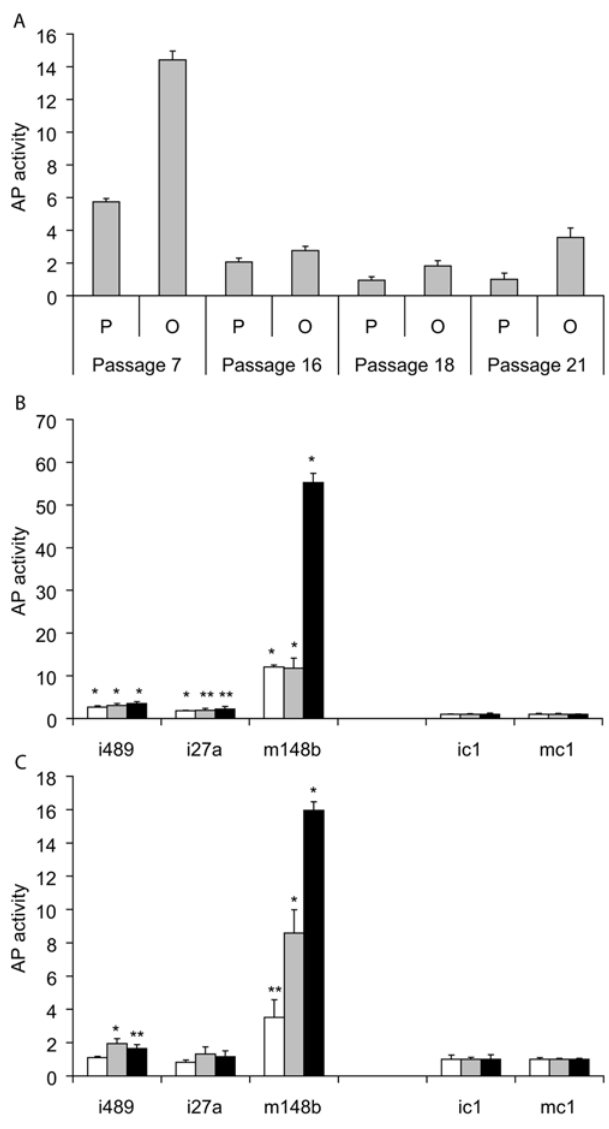
Figure 3. Alteration of the miRNAs activity rescues osteogenic potential in transfected hMSC with high passage number. (A) Bone marrow hMSC with high passage number demonstrate a decrease in basal level of AP activity and poor response to differentiation media. hMSC were plated in 96-well plates and incubated either in propagation (P, grey bar) or osteogenic (O, black bar) media for 6 days. Data normalized to relative AP activity values obtained from passage 21 hMSC incubated in propagation media. (B and C) Transfection with miRNA inhibitors and mimics restore differentiation in over-propagated hMSC incubated in propagation (B) or differentiation (C) media. hMSC propagated for certain number of passages (16, white bar, 18, grey bar or 21 , black bar) plated in 96-well plates and transfected with inhibitors and mimics (as indicated, all at 25 nM). Data are representative of three independent experiments performed in triplicate. (mean + / 2 SD). *, **: Student’s ttest p value between treated cells and corresponding control group, * - p , 0.01, ** - p ,